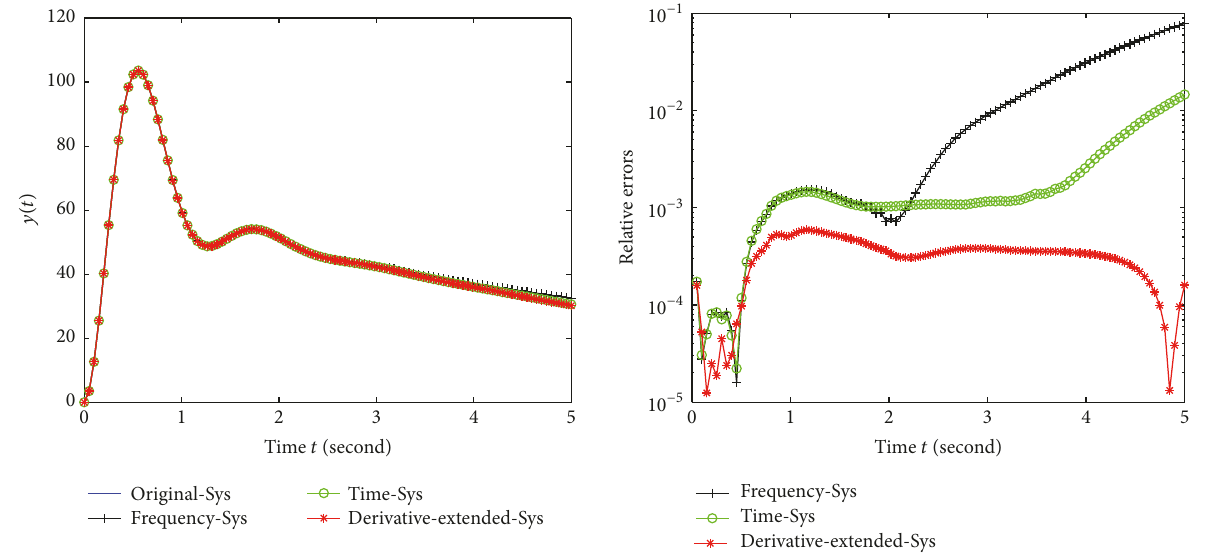
Figure 2: Outputs and relative errors for the input 𝑢(𝑡) = 𝑒 −2𝑡 sin (5𝑡)